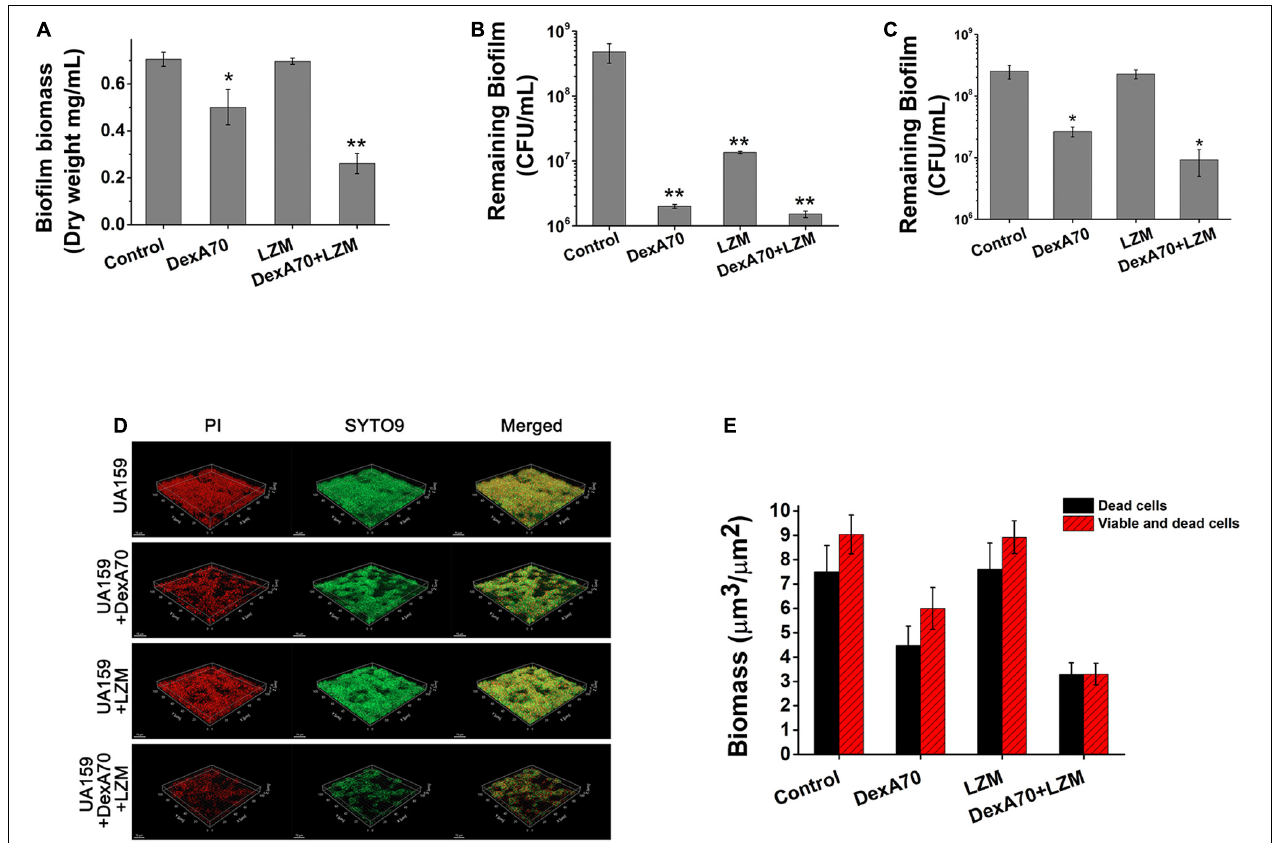
FIGURE 5 | DexA70 and lysozyme make a dispersing and killing strategy. (A) The dry weight of UA159 biofilm treated with/without DexA70 and lysozyme. Co-administration of DexA70 and lysozyme efficiently reduced biofilm biomass. (B,C) . CFU enumeration for remaining viable cells in biofilms treated with/without DexA70 and lysozyme. (B) Adding DexA70 and lysozyme (LZM) at the beginning of biofilm formation. (C) Adding enzymes after biofilm formation and incubating for 30 min. Experiments were performed in triplicate, and the results were shown as the mean ± SD. (D) LIVE/DEAD BacLight bacterial viability assay. Images show 12 h biofilm and cells prior to (0 min) and post 30 min of DexA70 and lysozyme treatment. Live bacteria are stained in green by SYTO 9 and dead bacteria are stained in red by propidium iodide. 63 × oil immersion magnification, scale bar = 15 µ m. (E) Biomass ( µ m 3 / µ m 2 ) of alive and damaged cells was calculated by processing CLSM stack images. Experiments were performed in triplicate, and the results are shown as the mean ± SD. Statistical significance is indicated as compared with negative groups untreated with enzymes using a t -test. * p < 0.05; ** p < 0.01.